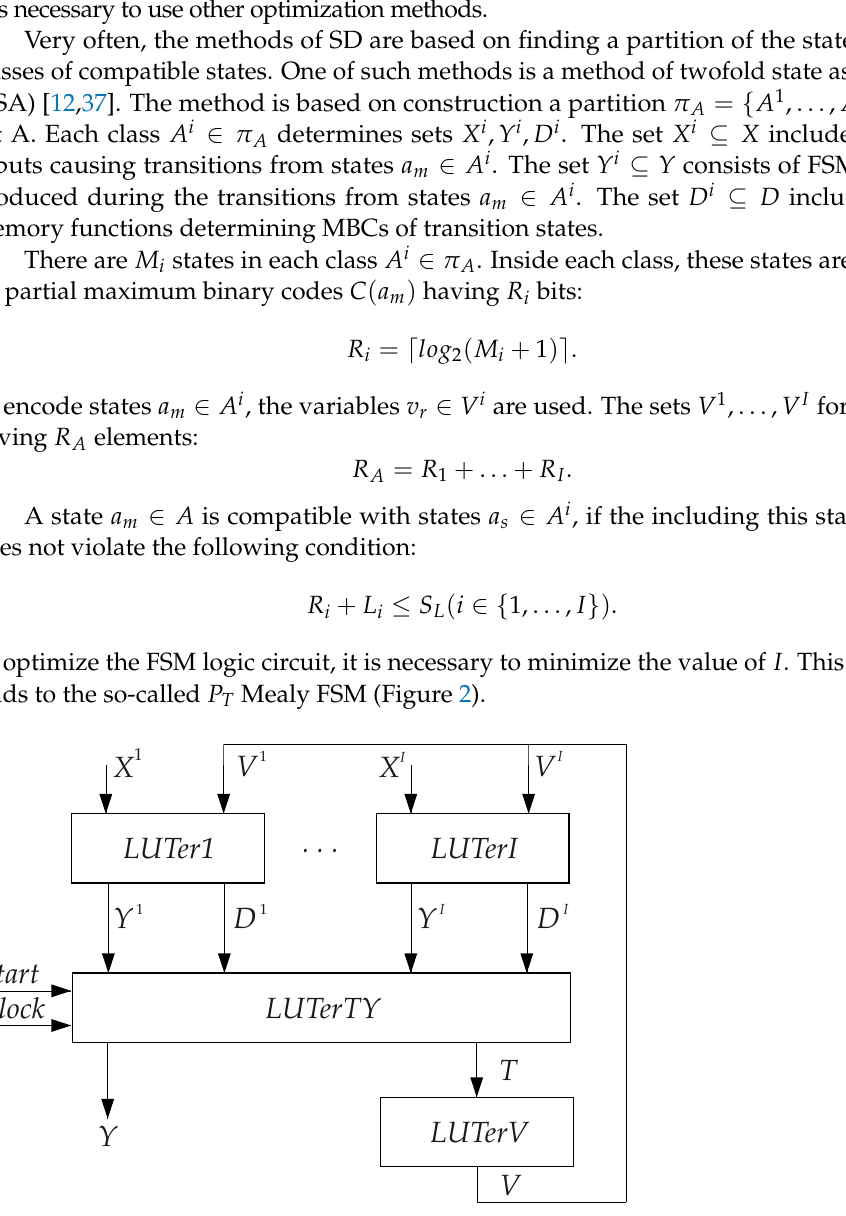
Figure 2. Structural diagram of P T Mealy